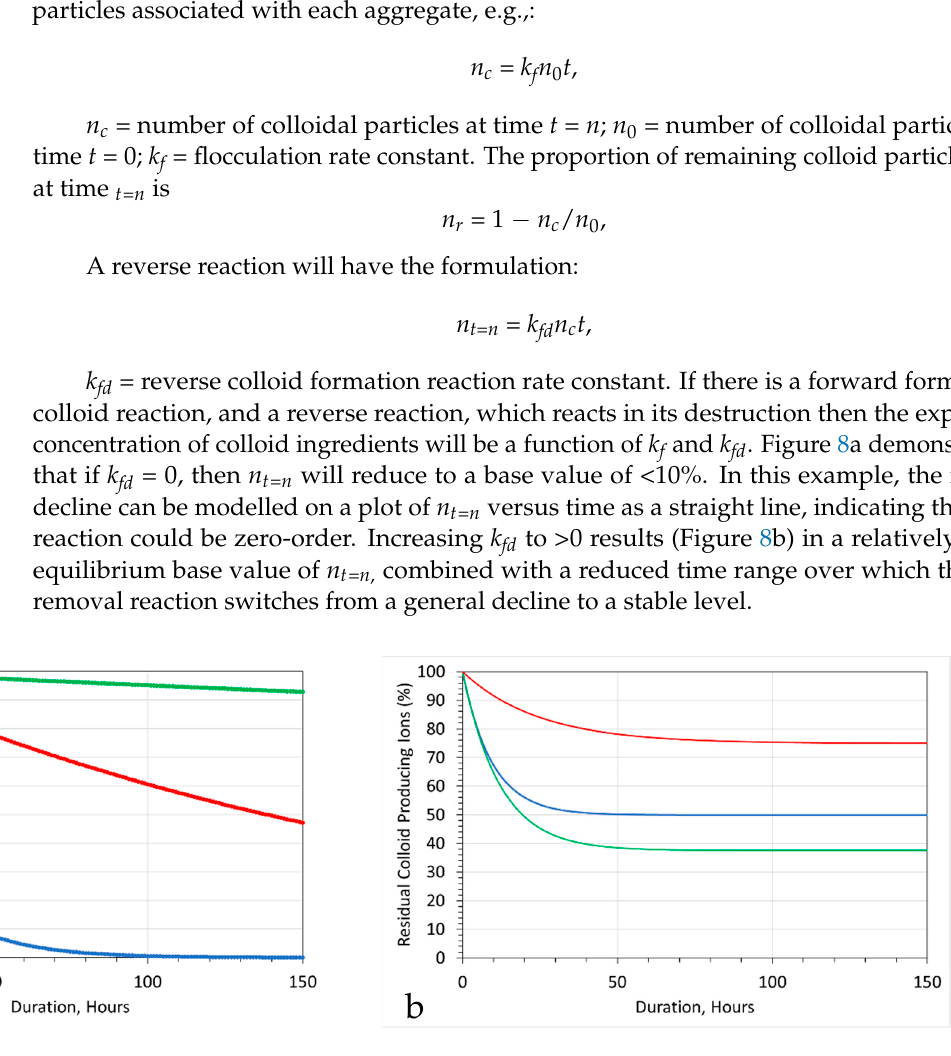
Figure 8. Colloid formation. ( a ), Residual colloid producing ions versus time. Assumptions: k fd = 0; Blue markers: k f = 0.05; Red markers: k f = 0.005; Green markers: k f = 0.0005. ( b ), Residual colloid producing ions versus time. Assumptions: k f = 0.05; blue markers: k fd = 0.05; green markers: k fp = 0.01; red markers: k f = 0.01; k fp = 0.03.